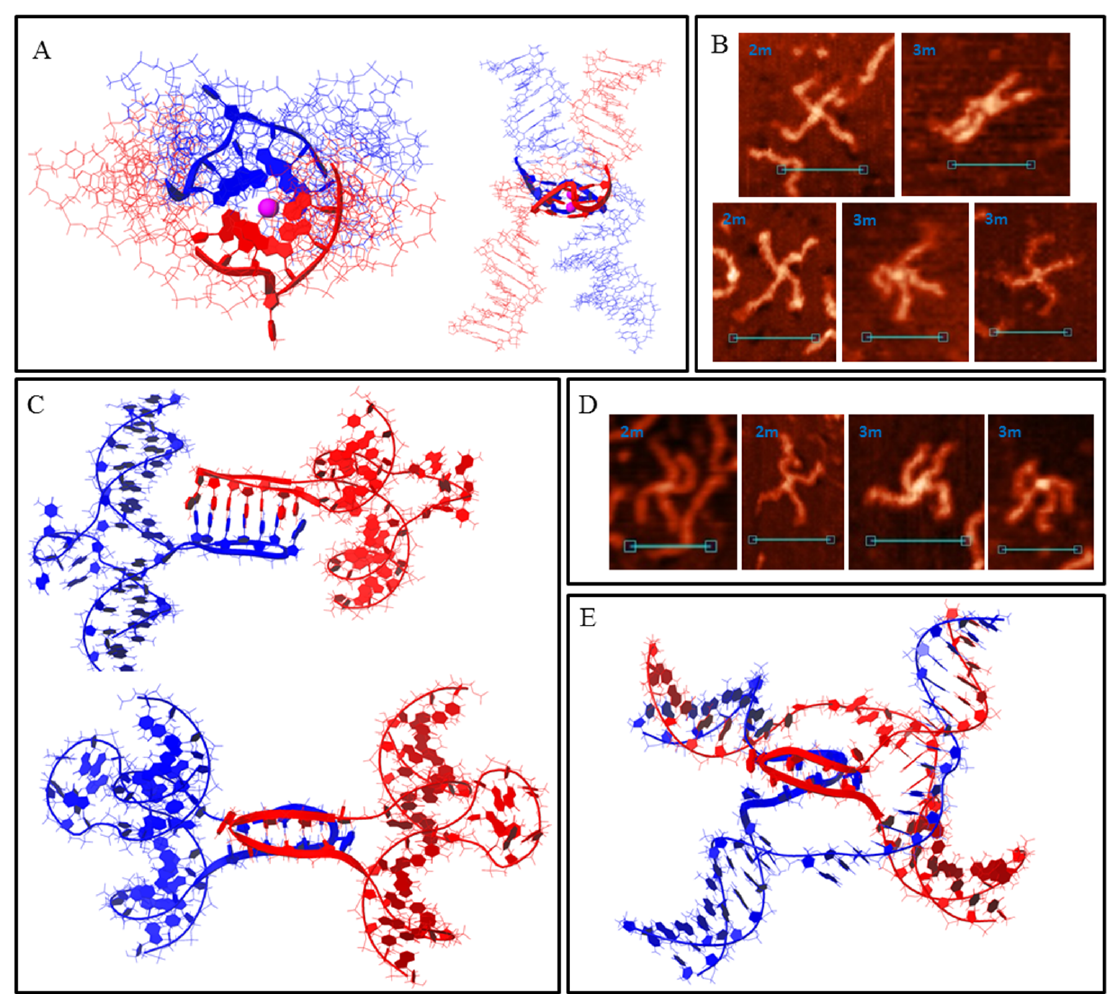
Figure 3. Bimolecular G4/IM-synaptic complexes formed by 2m and 3m samples. ( A ) Molecular model of duplex joining through intermolecular G4 folding. ( B ) Examples of the complexes consistent with model ( A ), revealed by AFM. Scale bars: 50 nm. ( C ) Molecular model of the joining through intermolecular IM folding. ( D ) Examples of the complexes consistent with model ( C ), revealed by AFM. Scale bars: 50 nm. ( E ) Molecular model of possible intermolecular IM formation upon Holliday structure